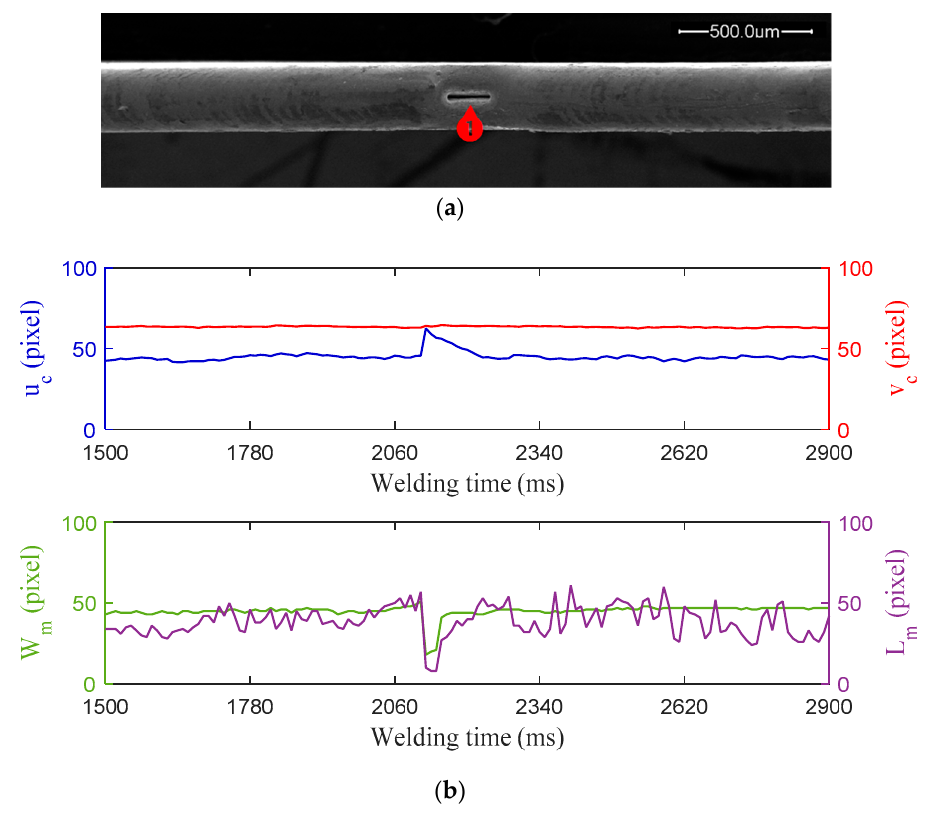
Figure 8. Experiment results with lack of fusion caused by surface contamination on workpiece: ( a ) Top-view of the edge weld profile observed under scanning electron microscopic (SEM) with 100× magnification; ( b ) Characteristic parameters of weld pool monitored during MPAW.